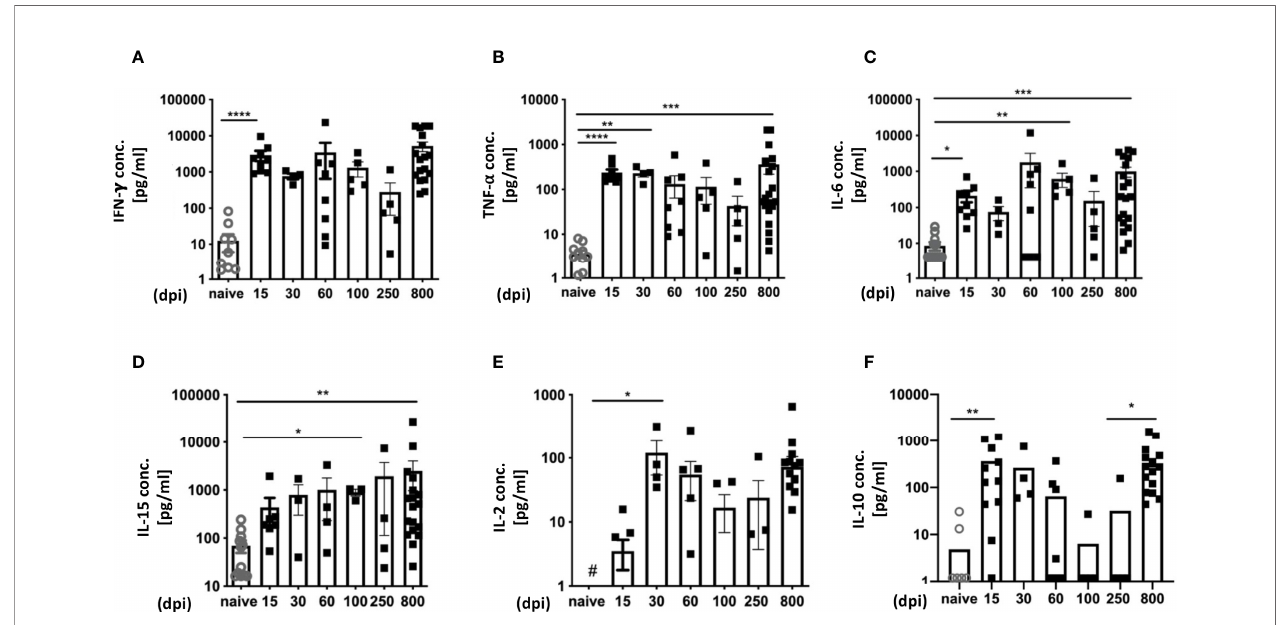
FIGURE 2 | Cytokine expression pro fi les reveal a strong in fl ammatory immune response over time. Analysis of cytokines in serum over the course of infection with T. cruzi was performed with a bead-based immunoassay to quantify multiple cytokines simultaneously with fl ow cytometry. The concentrations are given in pg/ml (A) for IFN- g , (B) TNF- a , (C) IL-6, (D) IL-15, (E) IL-2 and (F) IL-10. A total of n=63 mice were used; n.i. n=13; day 15 n=9, day 30 n=4; day 60 n=8, day 100 n = 4, day 250 = 5 and 800 n=20. Results are presented as mean ± SEM. Data from eight independent experiments were compared using the Kruskal-Wallis test and Dunn ’ s Multiple Comparison Test. # indicates a value below the detection limit of the assay. *p < 0.05, **p < 0.01, ***p < 0.001, ****p <